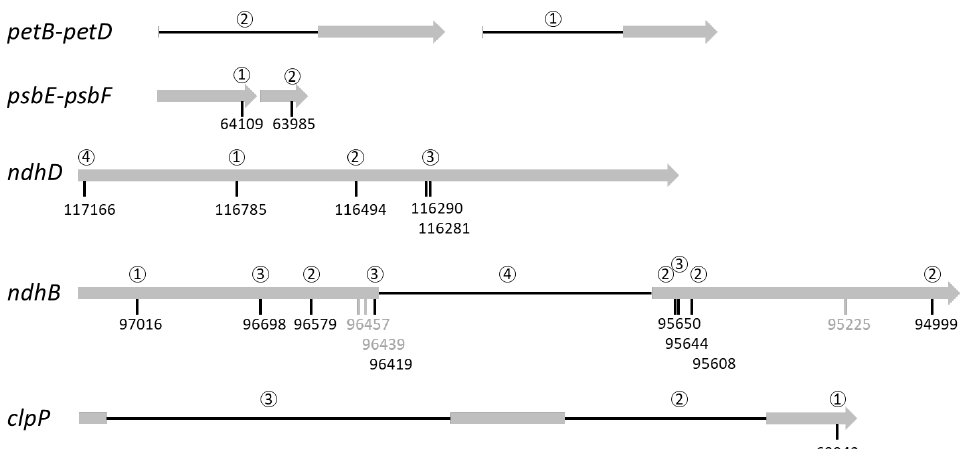
Figure 6. Proposed chronology of maturation events. Exons are shown as grey bars and introns as black lines. The editing sites are indicated by their genomic position. Grey editing sites are processed independently and thus are not included in the chronology. The preferred order of the maturation events is indicated by the numbers above the editing sites or introns.